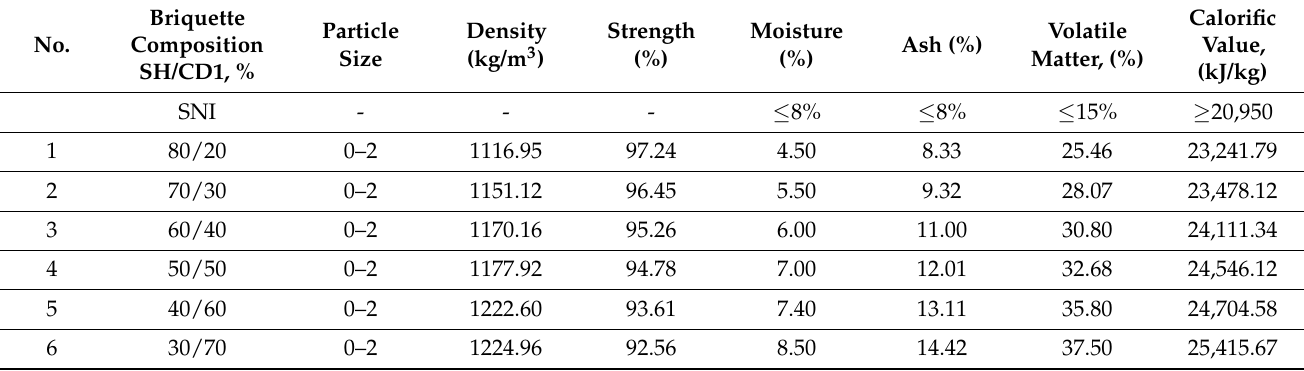
Table 8. The results of the analysis of briquettes (leaves and Karazhyra coal